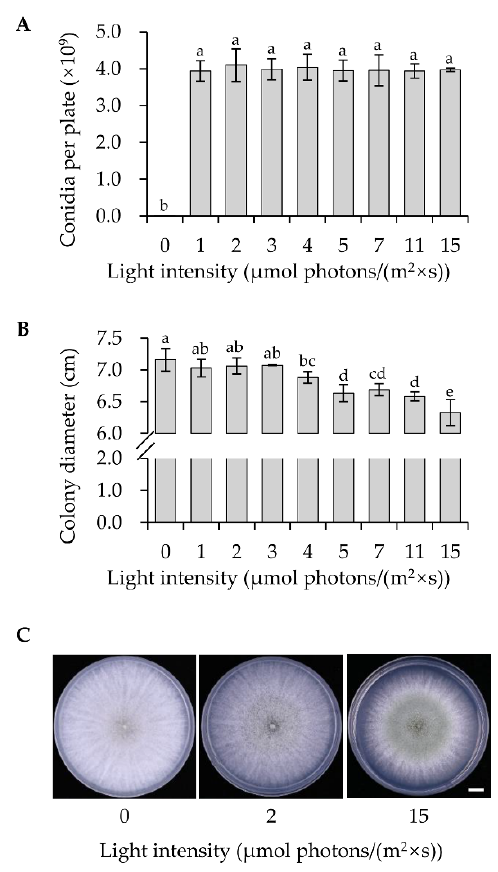
Figure 2. Effects of the intensities of blue light on vegetative growth and conidiation. ( A ) Quantifi- cation of the conidia produced in different intensities of blue light. Wild type was grown on the PDA medium at 28 °C for four days. The error bar represents the SD of three biological replicates. ( B ) Colony diameter of wild type in different intensities of blue light. The error bar represents the SD of three biological replicates. One-way ANOVA was used for the statistical analysis ( p ≤ 0.05). Means significantly different from each other do not share the same letter. ( C ) Phenotype of wild type grown in low and high intensities of blue light. The wild type strain was grown on the PDA medium at 28 °C for two days. Scale bar, 1 cm.